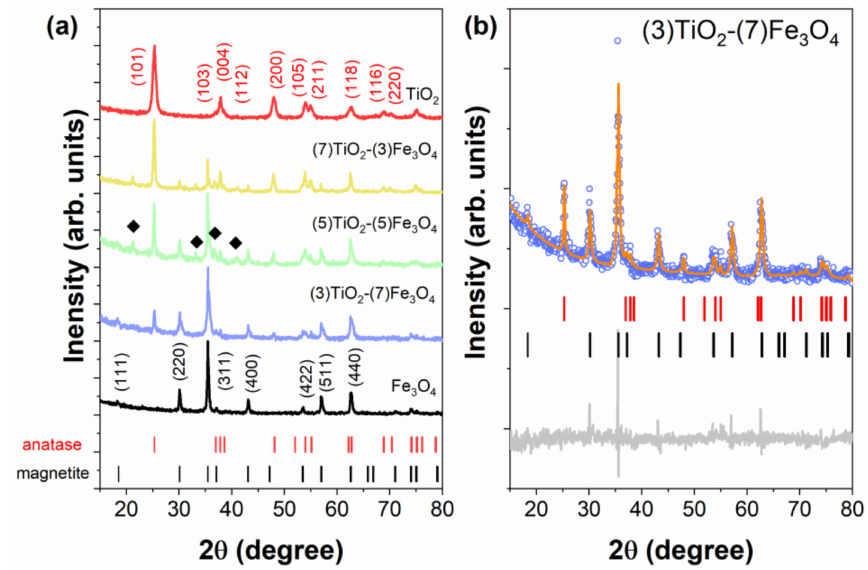
Figure 6. XRD patterns for all studied TiO 2 -Fe 3 O 4 composites and reference samples ( a ). Peaks marked by diamonds belong to the α -FeOOH impurity phases. For the most pronounced peaks, Miller indices are given. ( b ) XRD pattern (open circles) and Rietveld refinement (solid orange line) for the selected (3)TiO 2 -(7)Fe 3 O 4 composite sample. The di ff erence curve of the experimental and calculated intensity is shown at the bottom. The upper and lower ticks represent Bragg positions corresponding to the anatase and magnetite phases,